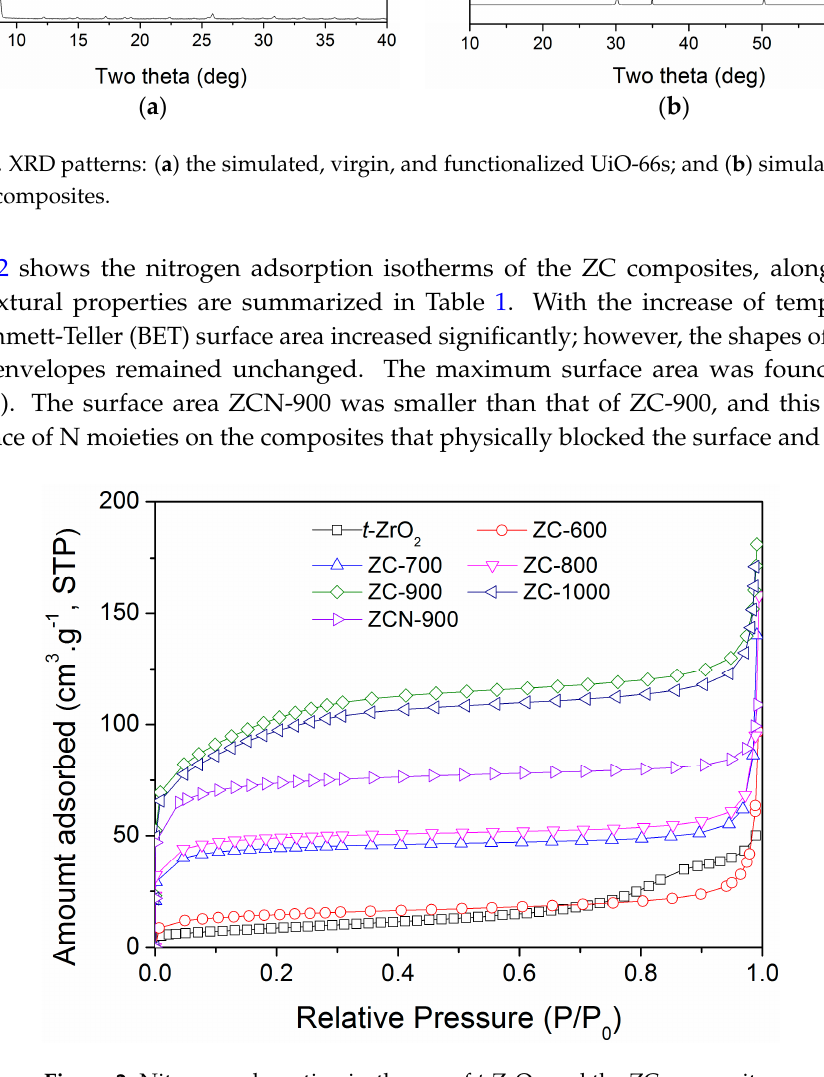
Figure 2. Nitrogen adsorption isotherms of t -ZrO 2 and the ZC composites.